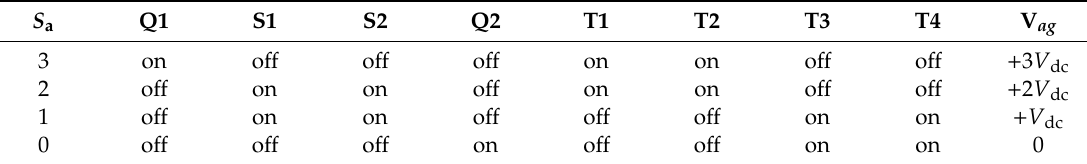
Table 1. Voltage transition and switching states in leg